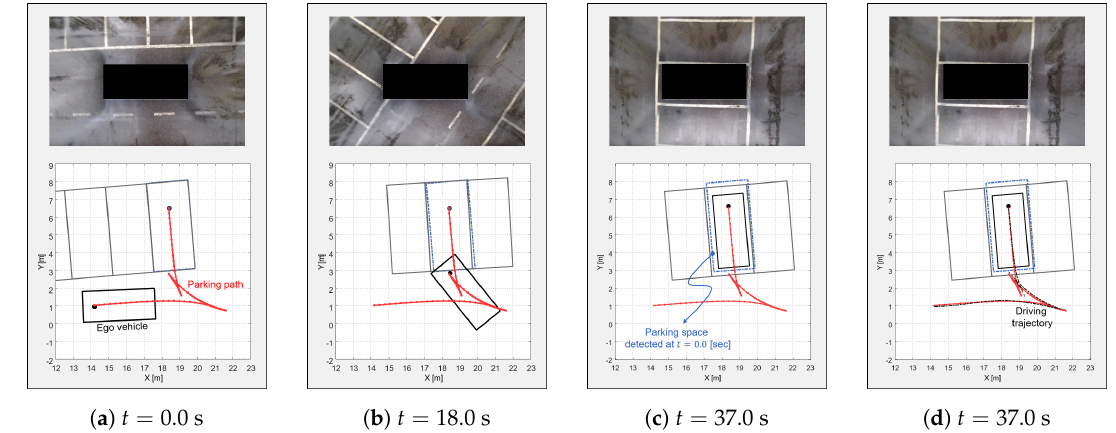
Figure 12. The open scenario without re-planning; there were position and orientation differences between the first ( a ) and last detected parking spaces ( c ).